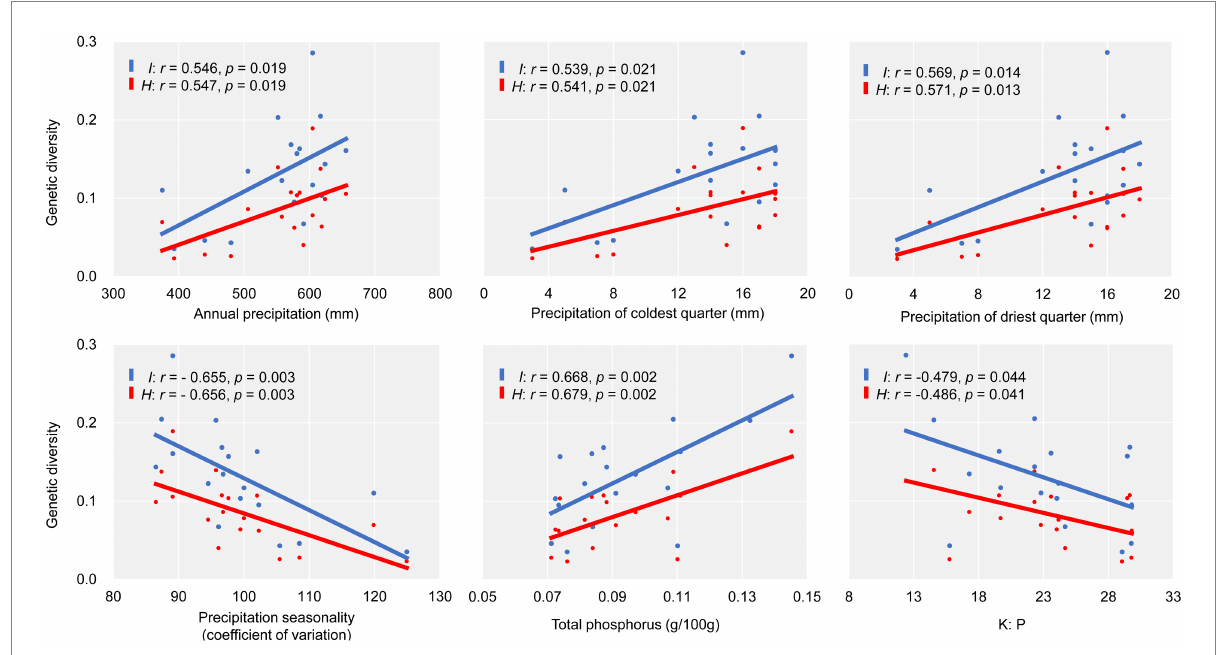
FIGURE 6 Scatter plots showing the relationships between two genetic diversity parameters ( I , H ) and environmental factors.